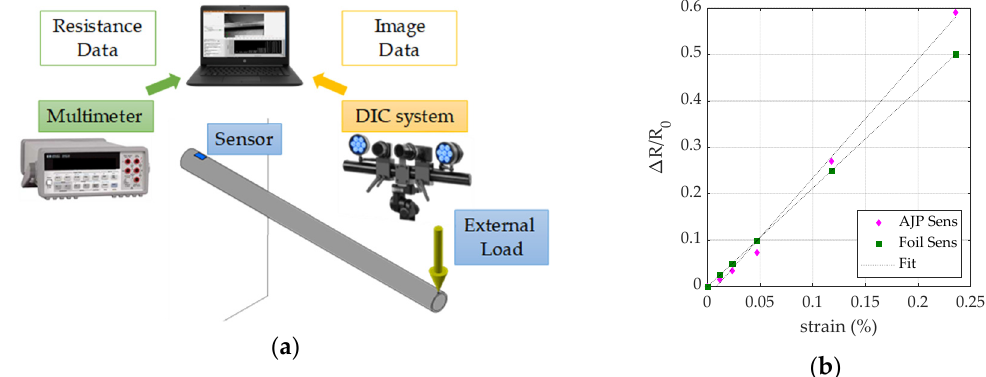
Figure 7. ( a ) Experimental setup for tested the response of the printed strain gauge under axial stress and ( b ) experimental results compared with the ones of the commercial strain gauge.